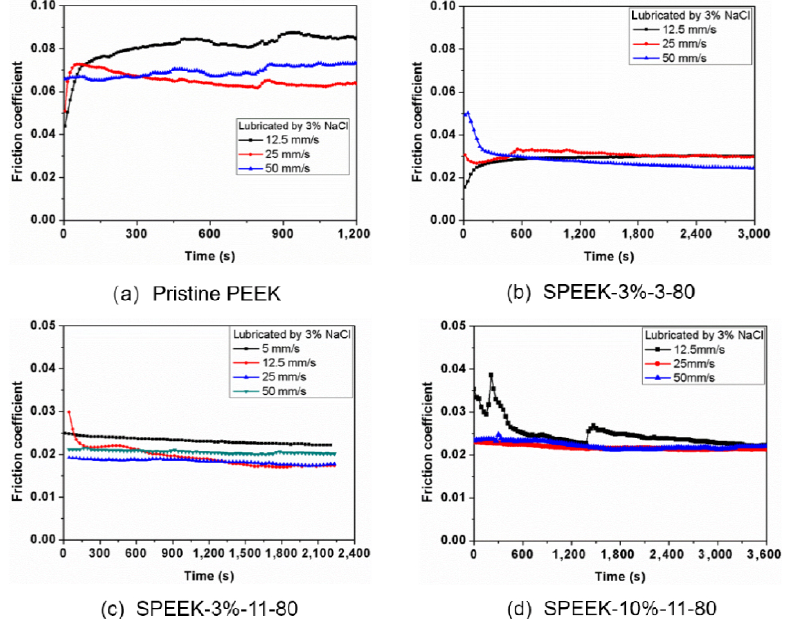
Fig. 4 Tribological characteristics of the pristine PEEK and sulfonated PEEK samples. Friction coefficients between Si 3 N 4 ball and (a) pristine PEEK, (b) SPEEK-3%-3-80, (c) SPEEK-3%-11-80 discs. The friction coefficients decreased after the sulfonation of the PEEK powder